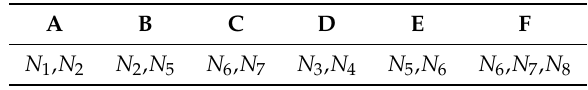
Figure 5. Node n and its forwarding set. Table 1. The competitor set of